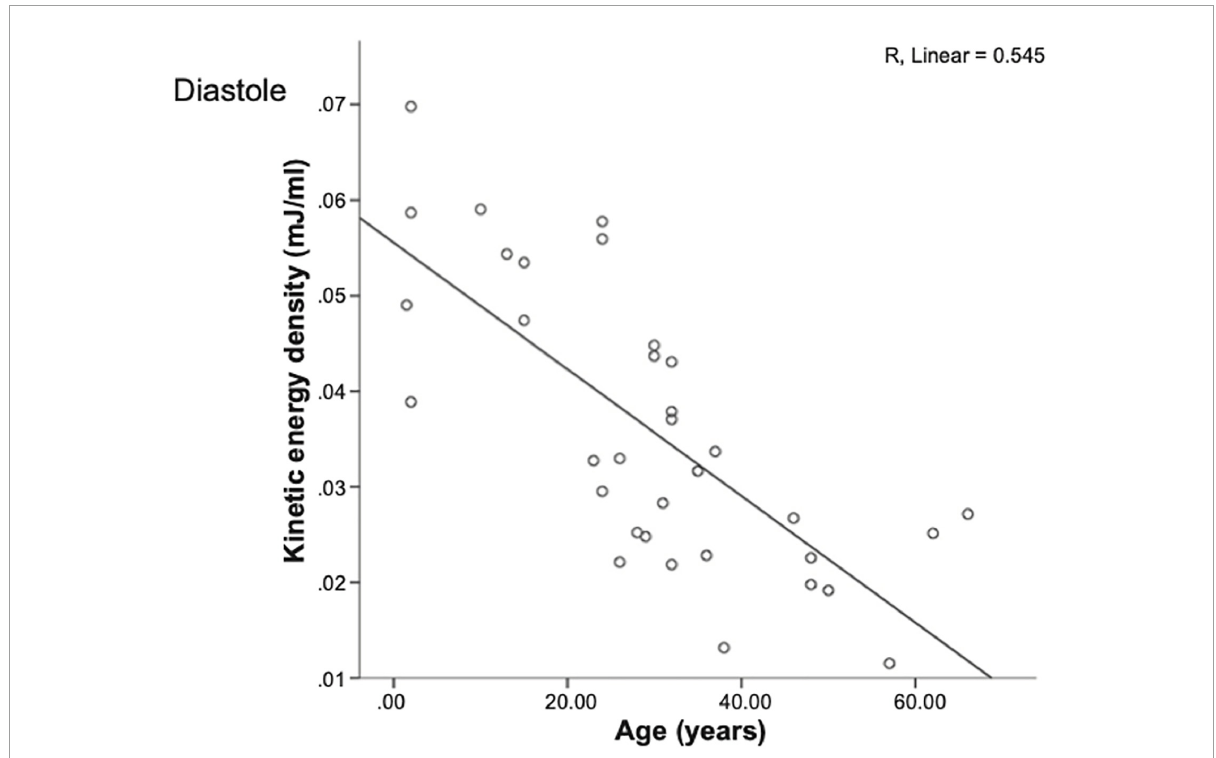
FIGURE2 Peak left ventricular KE/ml in early diastole for healthy individuals with age (30). Early diastolic peak left ventricular KE/ml (generated during active relaxation) declines with increasing